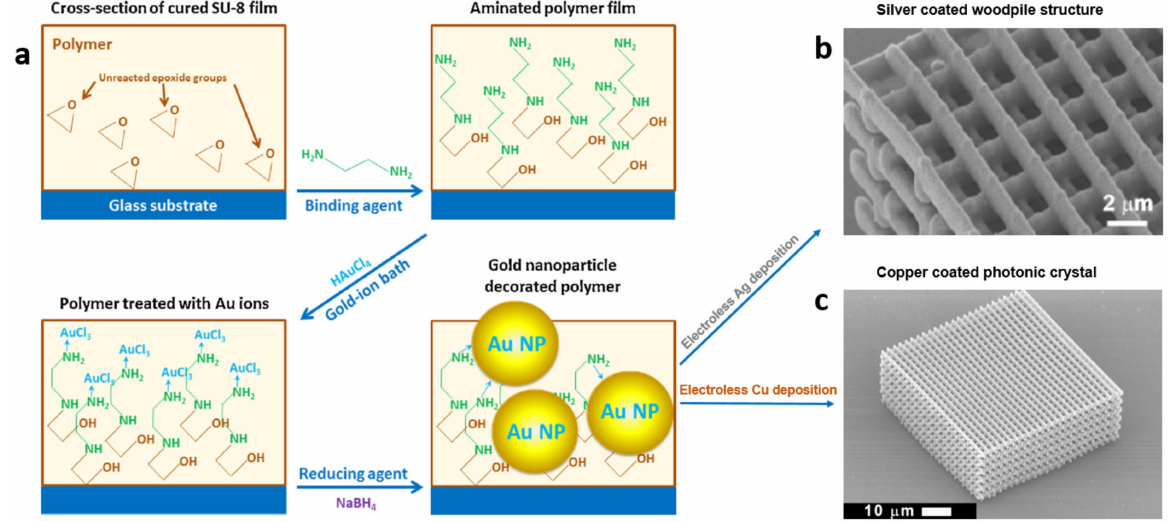
Figure 14. Au-NP-assisted conformal deposition of metals on the surface of SU-8 micro-structures fabricated by MPL. ( a ) Schematic illustration of Au NP deposition on SU-8 surface. Reprinted with permission from Ref. [114] Copyright 2014 Elsevier. ( b ) SU-8 woodpile structure fabricated by MPL and coated with silver via Au-NP-assisted electroless deposition. Reprinted with permission from Ref. [116] Copyright 2007 American Chemical Society. ( c ) SU-8 photonic crystal fabricated by MPL and metallized with copper via Au-NP-assisted electroless deposition. Reprinted with permission from Ref. [34] © The Optical